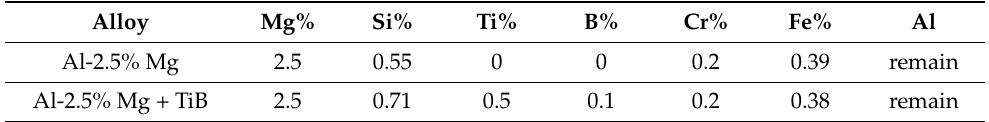
Table 1. Chemical composition of investigated alloys, wt %.